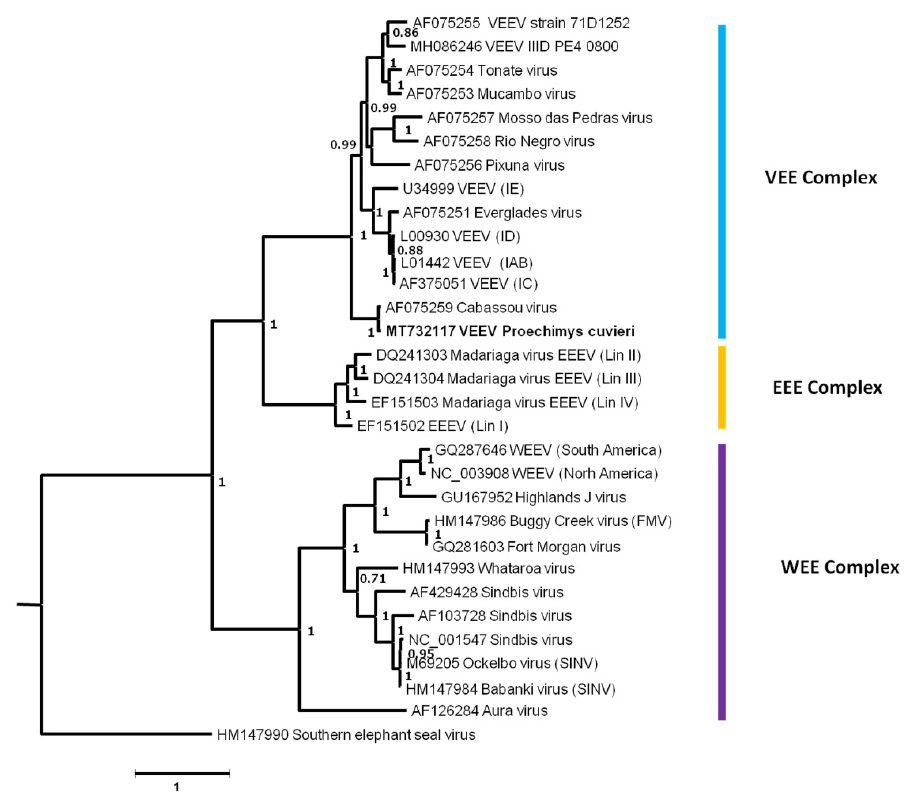
Figure 7. A phylogenetic tree based on one fragment of the structural protein (alignment of 1989 nucleotide positions) of each well-known representative of an alphavirus antigenic complex. The tree was inferred from nucleotide sequences using the Bayesian method with the GTR + G (general time reversible) model. Sequence identifiers include the NCBI accession number and the isolate name. The posterior probability of the Bayesian analysis (>70%) is shown next to each node. The scale bar indicates the (nucleotide) substitution rate. The sequence of P. cuvieri VEE is highlighted in bold and the main antigenic complexes are indicated.